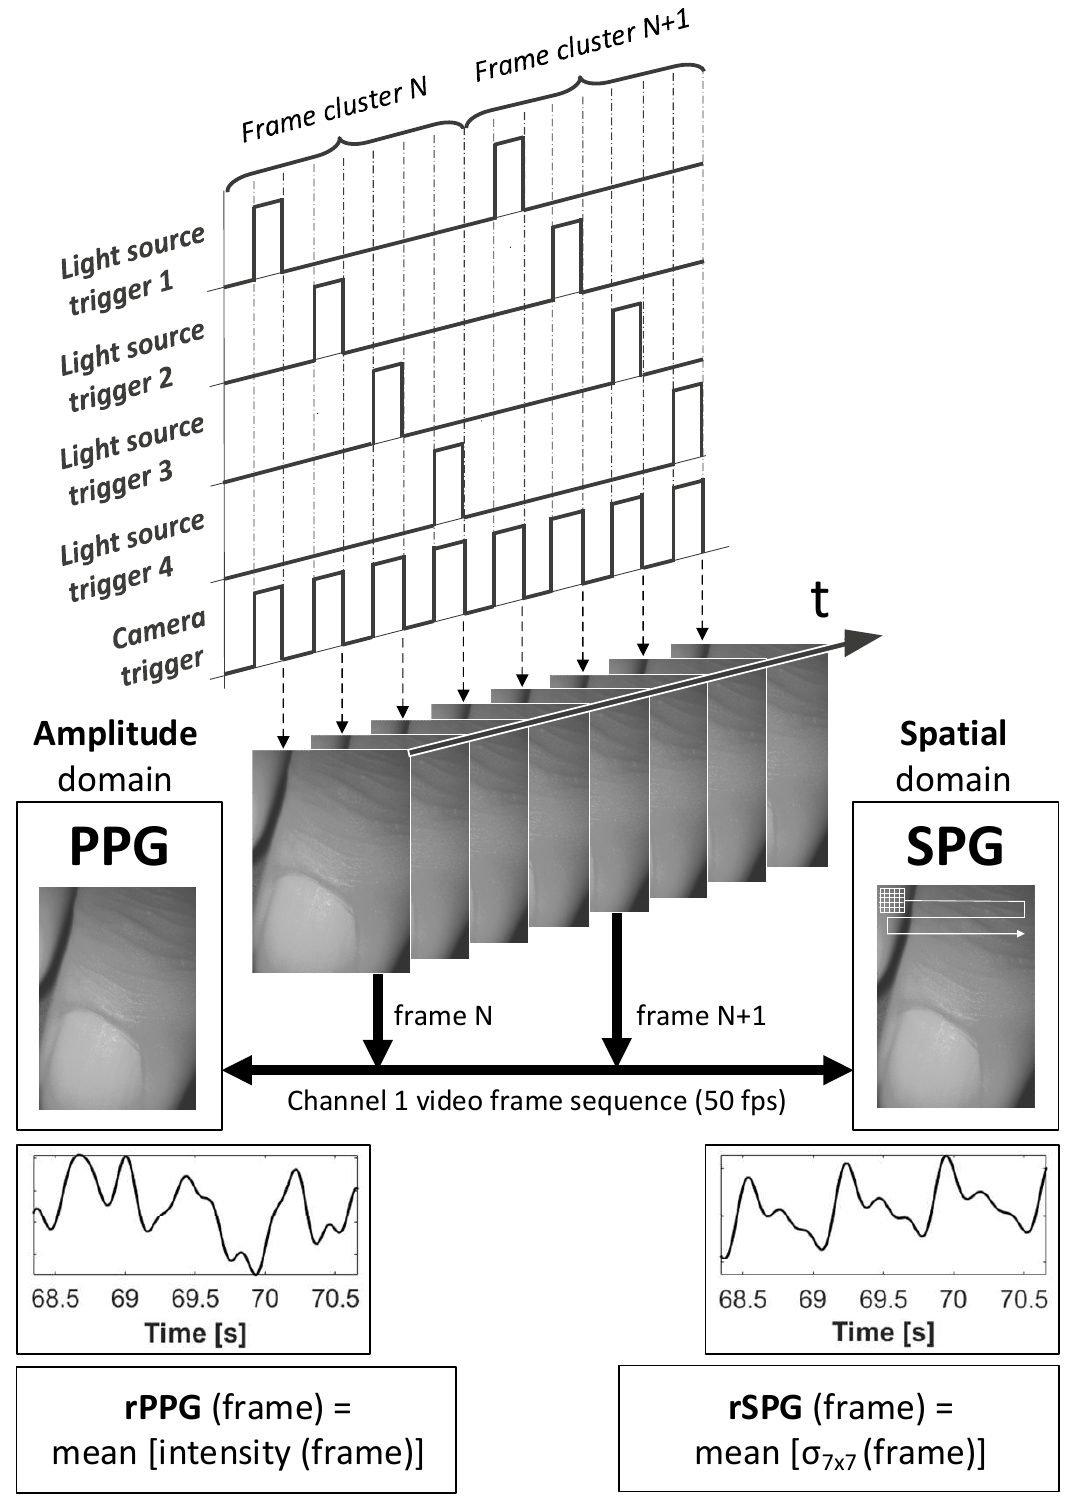
Figure 3. Raw camera video frames are captured at 200 fps and by time-domain-multiplexing split-up into 4 channels, each pulsing a different light source at 50 fps. Two different processing methods—amplitude domain and spatial domain—are both applied to the same video stream. Here, we show rPPG versus rSPG for Channel 1. Note that raw waveforms are displayed vertically inverted, as is common practice for commercial PPG and SPG signal outputs.